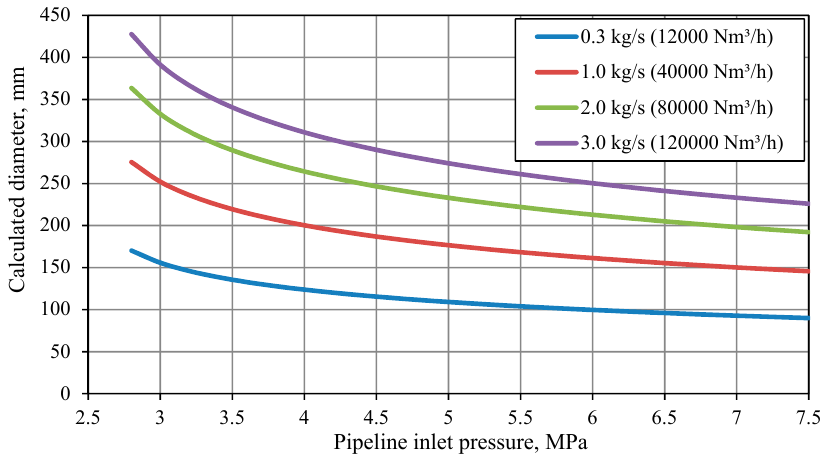
Figure 4 . Diameter calculation for pure hydrogen pipeline as a function of pipeline inlet pressure. Energies 2019 , 12 FOR PEER REVIEW